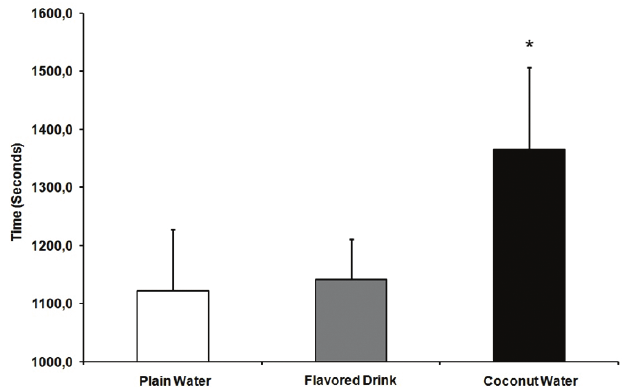
Figure 1. Cycling time to exhaustion (seconds) in the heat (34ºC) after ingestion of plain water, flavored drink and coconut water. *Different from plain water and flavored drink, p